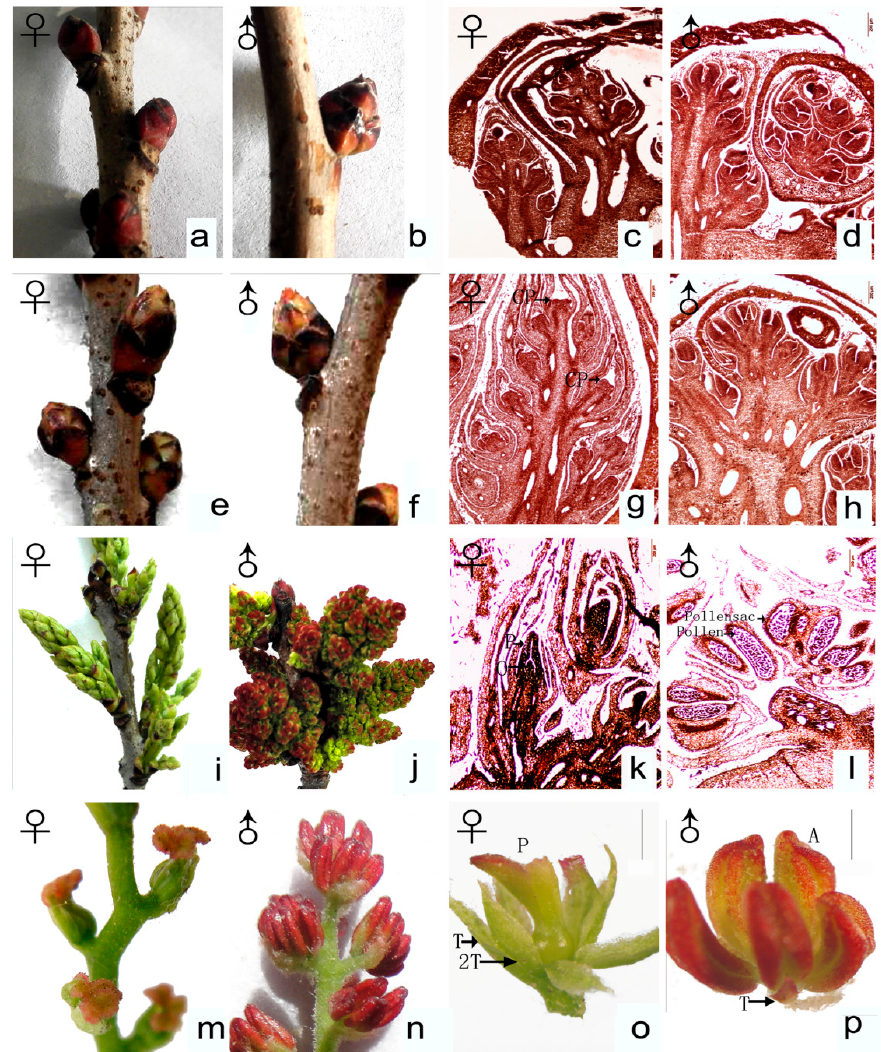
Figure 6. The external and internal morphological changes of female and male flower buds (inflorescences) during the sex organ development phase in monoecious Pistacia chinensis .